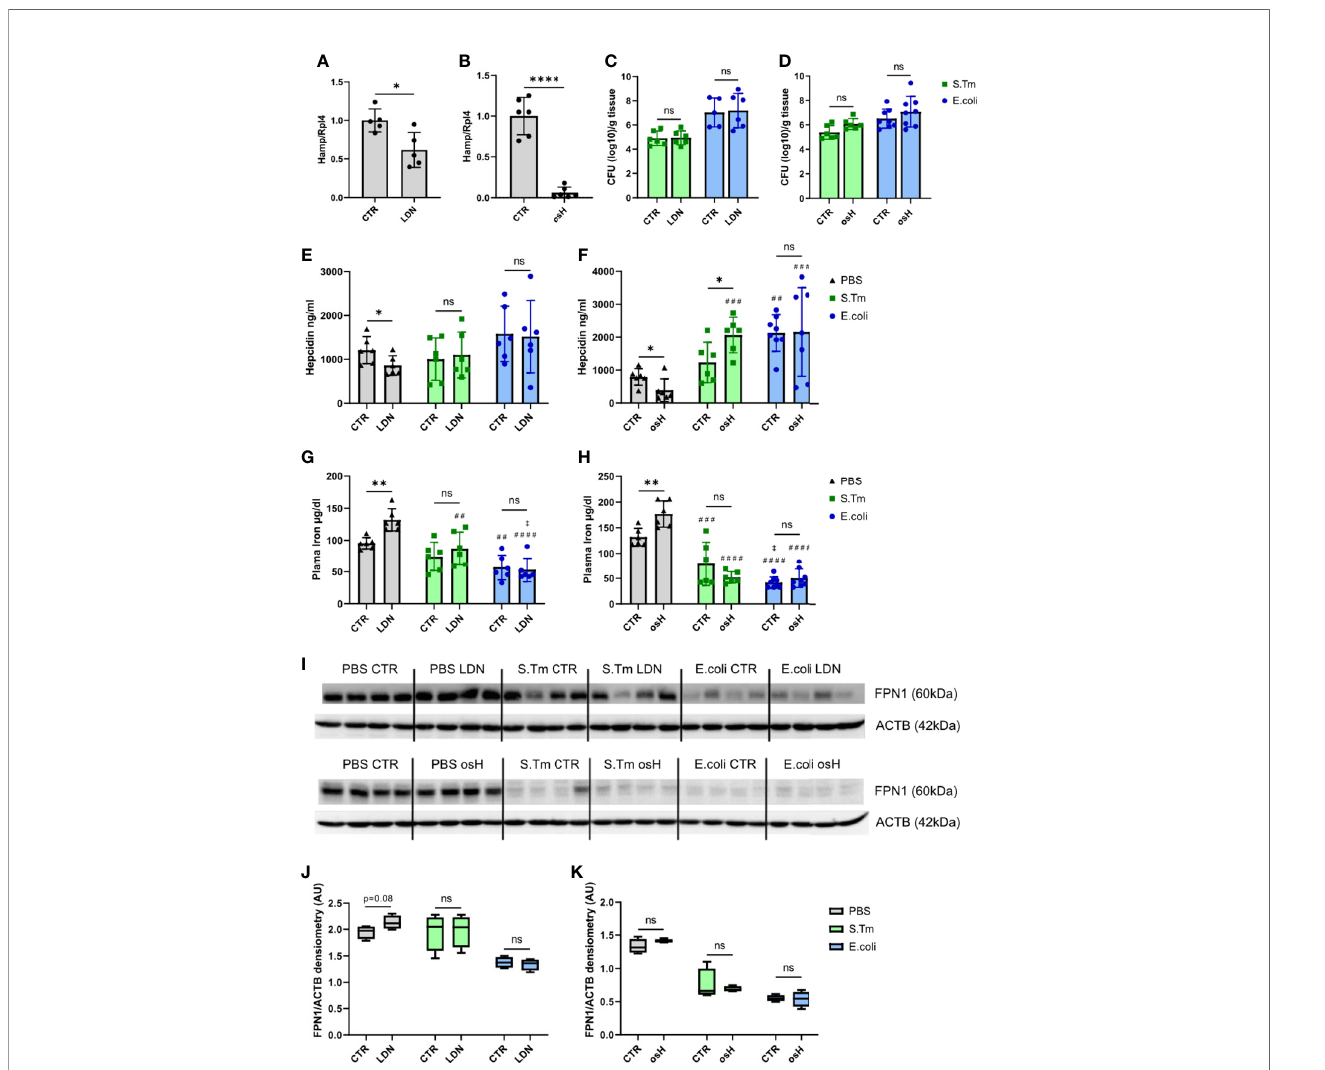
FIGURE 2 | LDN-193189 and oversulfated heparins inhibit hepcidin in vivo in uninfected mice but no in infected mice. Ten weeks old, male, C57BL/6N mice were treated with (A) 3mg/kg-bodyweight LDN-193189 (LDN) or (B) 40mg/kg-bodyweight of oversulfated heparins (osH) for 18h. The mice received an injection of the inhibitor or the vehicle (CTR) at time point 1h prior to infection and a second dose11h after infection. Mice were infected with 1.1 x 10 6 colony forming units (CFU) of either Salmonella Typhimurium (S.Tm), Escherichia coli ( E.coli ) or just PBS as a control. Splenic bacterial load of mice receiving (C) LDN or (D) osH. Plasma hepcidin of mice receiving (E) LDN or (F) osH was measured using an ELISA. Plasma iron of mice receiving (G) LDN or (H) osH. (I) Protein levels of splenic ferroportin (FPN1) and actin (ACTB) as a reference of infected mice receiving the two different hepcidin inhibitors and (J, K) the quanti fi cation of the Western blot results. Each dot indicates a single mouse. (A, B) n=5 per group, (C – H) n=5-8 per group. One statistical outlier was excluded in (F) for E.coli/osH. For (I) 4 representative samples of each group were chosen. A two-way ANOVA was performed where more than 2 groups existed and a student t-test was performed for results with only 2 groups. *p < 0.05, **p < 0.01, ****p < 0.0001, ns, no signi fi cance of differences; # signi fi cantly different from uninfected mice, ## p<0.01, ### p < 0.001, #### p < 0.0001; ‡ signi fi cantly different from S.Tm infected mice, ‡